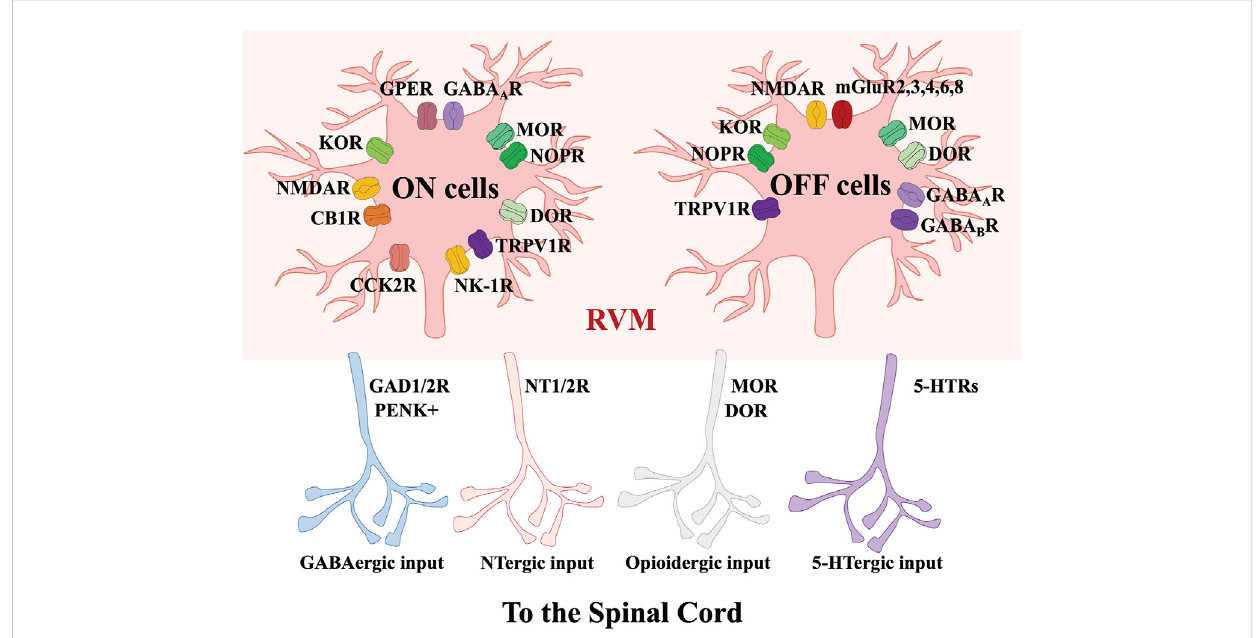
Molecular characteristicsof RVM-spinal cord circuits modulating nociception. Via acting onGAD,5-HTRs,NTand opioid receptors,theprojections from RVM ON and OFF cells to the spinal cord contain GABAergic, NTergic, opioidergic and 5-HTergic